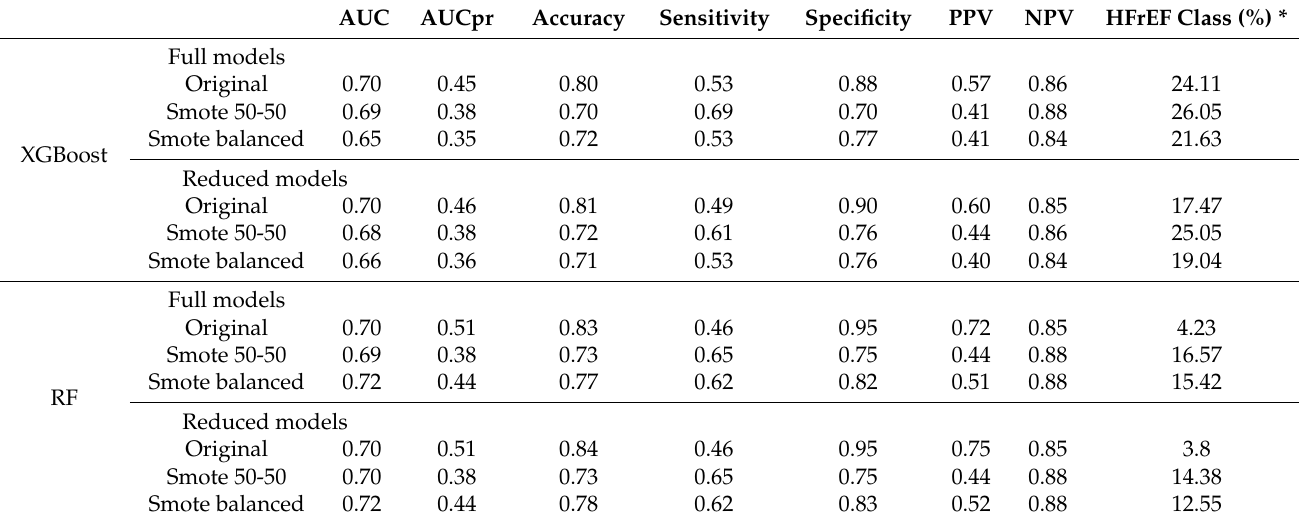
Table 3. Performance measures of the predictive models in the Testing Dataset.